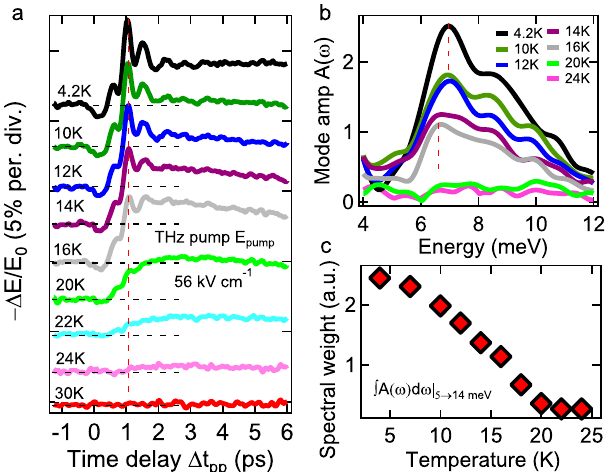
Fig. 2 Temperature dependence of hybrid Higgs mode coherent oscillations in FeSCs. a Temporal pro fi les of − Δ E / E 0 at various temperatures and for a peak THz pump E- fi eld of E pump = 56 kV/cm. Traces are offset for clarity. b Fourier spectra of the Higgs mode oscillations derived from the two-pulse coherent pump – probe signals at different temperatures. Dashed red lines indicate the slight redshift of the Higgs mode frequency with the drastic reduction of mode SW as a function of temperature. c Temperature dependence of the integrated SW 5 → 14meV of the Higgs mode in b